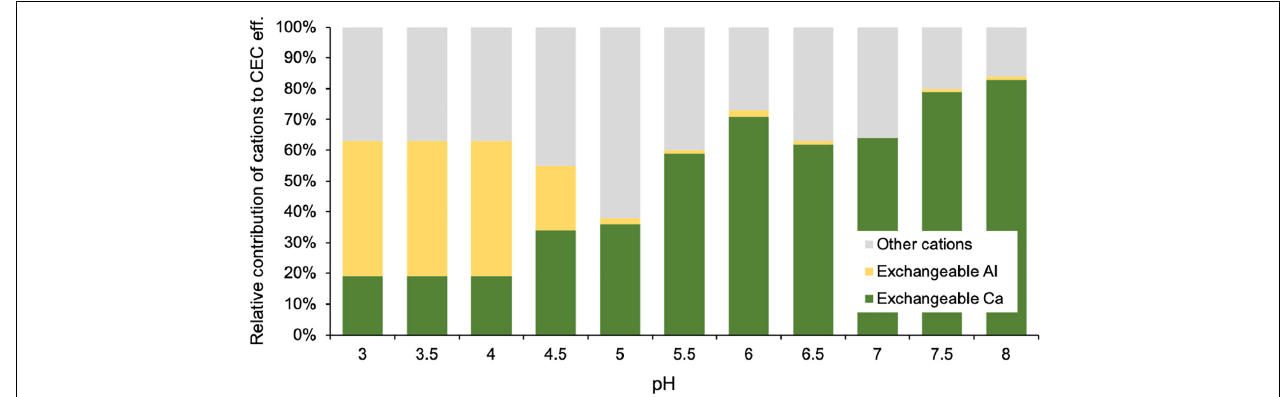
FIGURE 5 | Relative contribution of exchangeable Ca, Al and other cations (Na + , K + , Mg 2 + , Mn 2 + , Fe 2 + , H + ) to the effective cation exchange capacity (CEC eff.) across different pH classes in subsoils (30–120 cm depth) of Swiss forests. TABLE 3 | Results of the linear model used to analyze how the variance of subsoil organic carbon (30–120 cm depth) is influenced by the effective cation exchange capacity (CEC eff.) and other environmental variables. pH ≤ 5.5 pH >